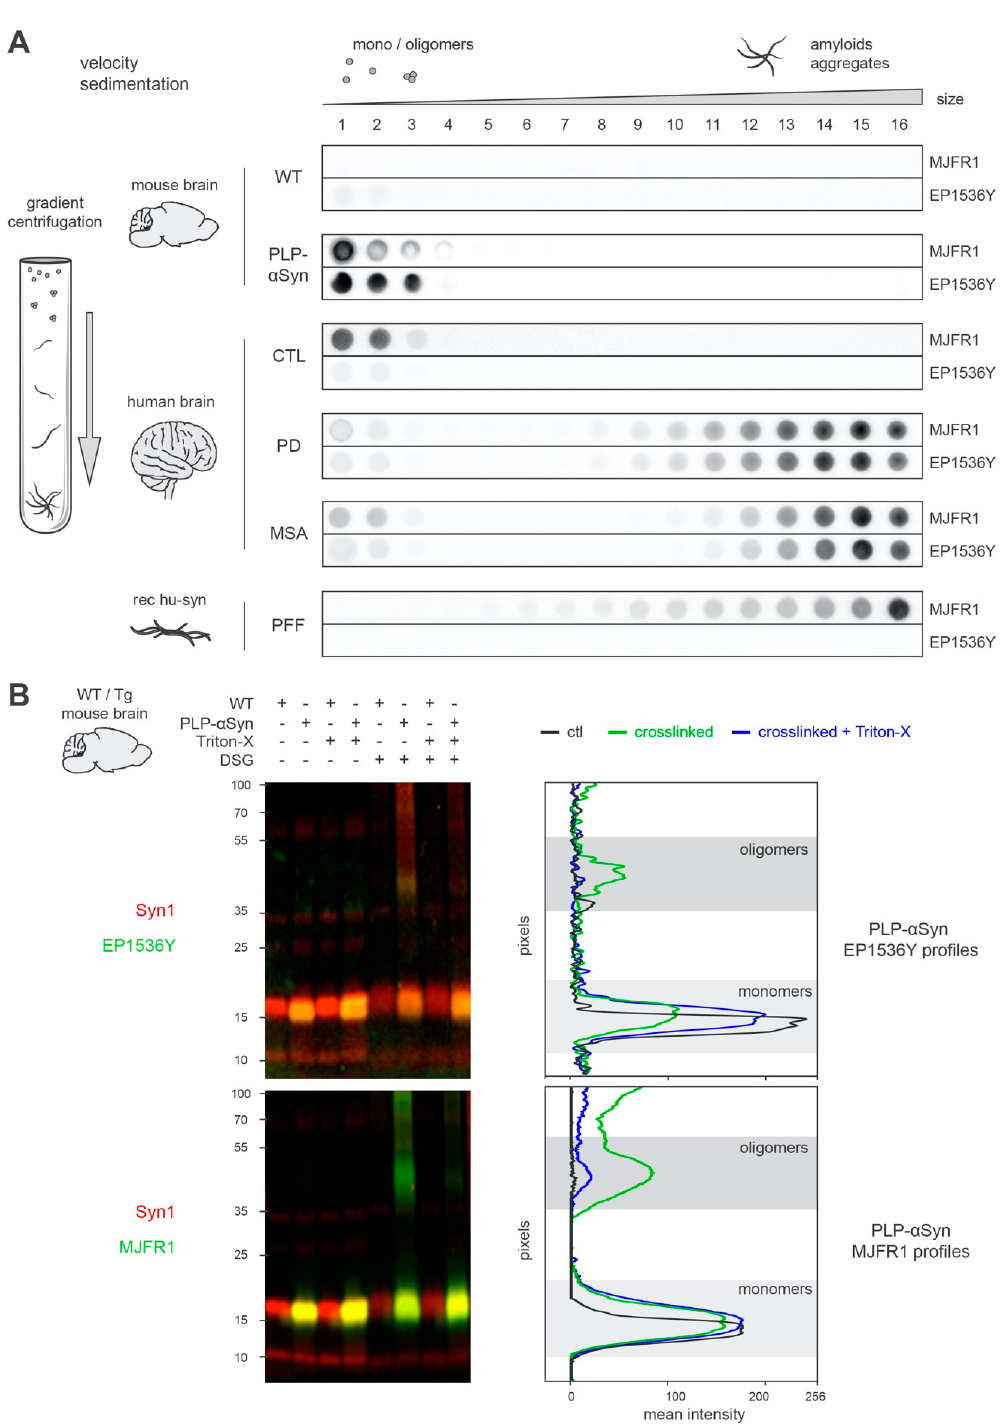
Figure 2. Unlike in MSA and PD, S129-phosphorylated human α -syn is oligomeric and monomeric in PLP- α Syn mouse brains. ( A ) Aggregation profiles obtained by sedimentation of the different species of α -syn found in WT or PLP- α Syn mouse brains ( top ), control, PD and MSA human subject brains ( middle ) or a preparation of recombinant human α -syn PFF ( bottom ). Pooled mouse ( n = 3) or human ( n = 3) brain homogenates and PFF samples were subjected to SarkoSpin solubilization followed with fractionation by sedimentation velocity upon ultracentrifugation on iodixanol gradient. The distribution of human α -syn (MJFR1) and pS129- α -syn (EP1536Y) was analyzed by